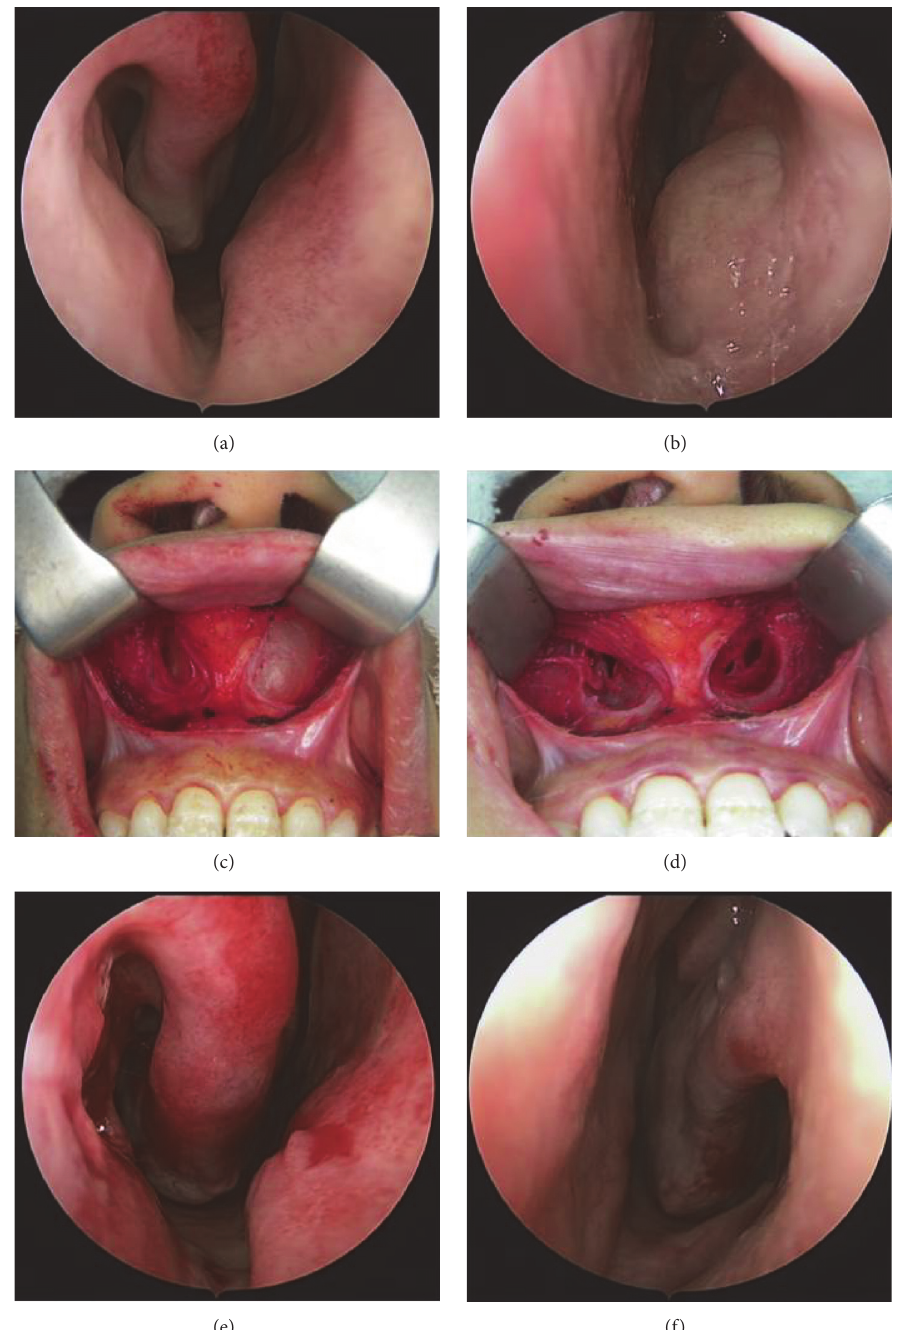
Figure 2: Intraoperative image of the cysts that were excised by sublabial approach. The cyst on the right was reduced in size because it ruptured due to an infection, but the cyst on the left kept narrowing the inferior meatus in the vestibule floor (a, b). In the intraoperative assessment fibrotic adhesions of the cyst on the right due to infection were seen, while the left cyst’s borders were seen to be easily separated from the surrounding structures (c, d). After the cysts were totally excised nasal obstruction also passed (e,